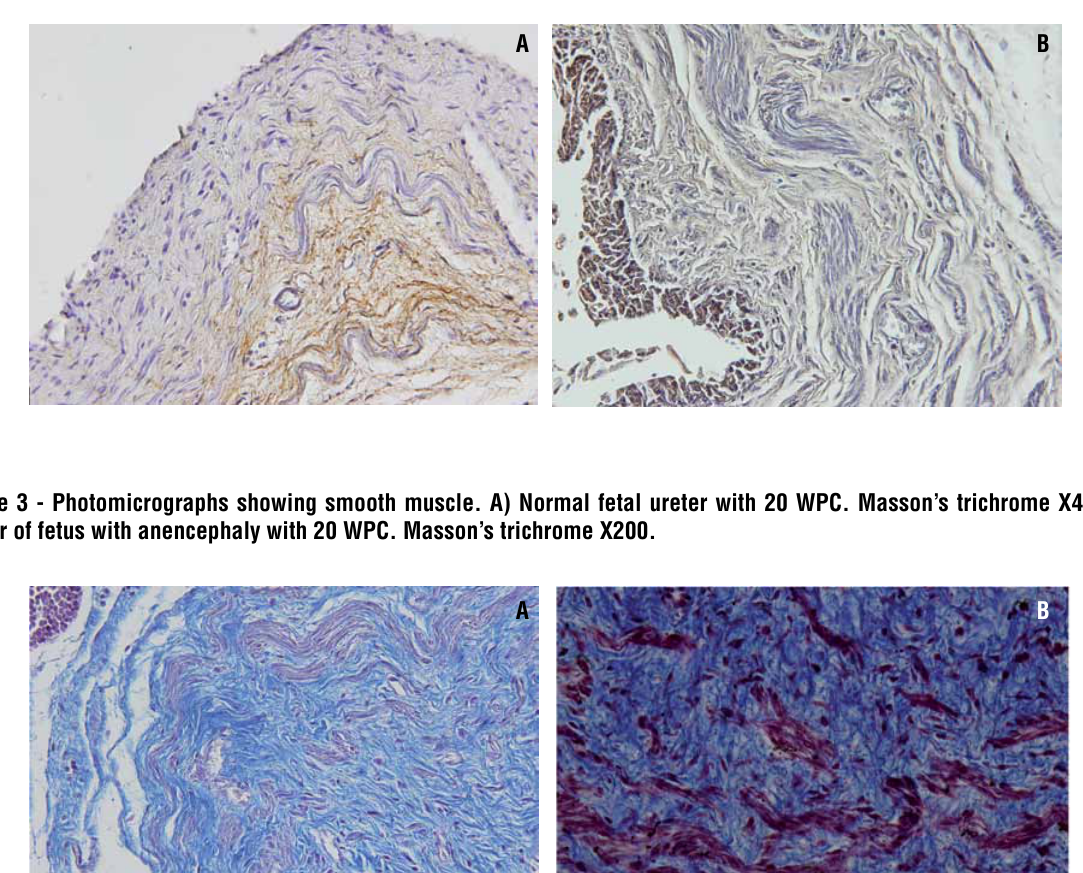
Figure 2 - Photomicrographs showing the elastic system fibers (Brown). A) Normal fetal ureter with 27 WPC. Anti-elastin